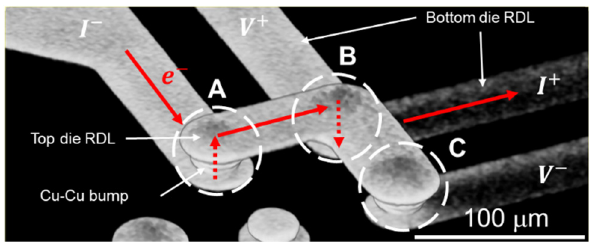
Figure 3. Nondestructive observation of Kelvin bumps. The resistance of the corner bump, named Kelvin bump B, can be measured. Kelvin bump A is under the same current stress during the EM test. Kelvin bump C connects with the 𝑉 (cid:2879) probe pad.